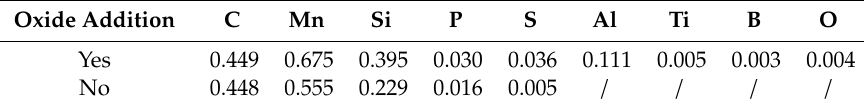
Table 1. Chemical compositions of the steels used in this research